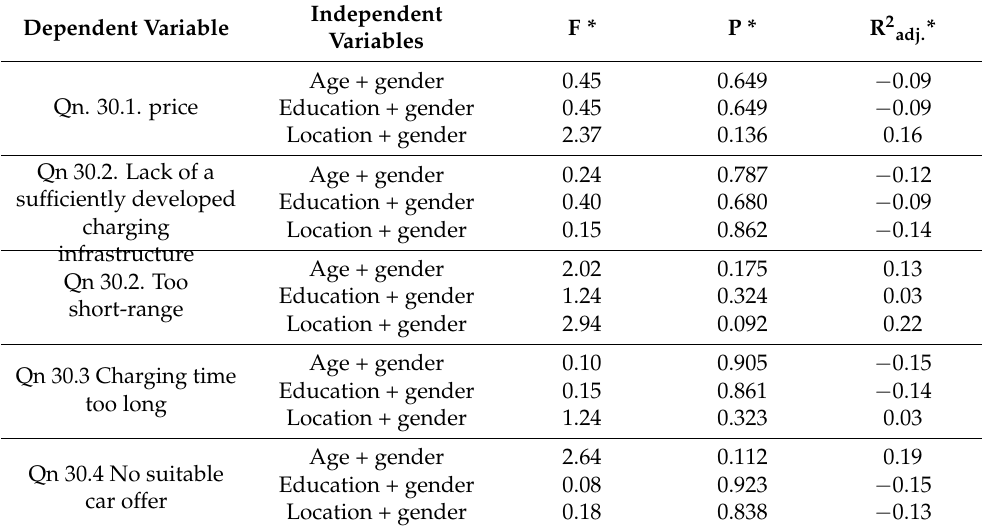
Table 10. Linear regression results for factors that least influence electric vehicle purchase abandon- ment (for question 30).